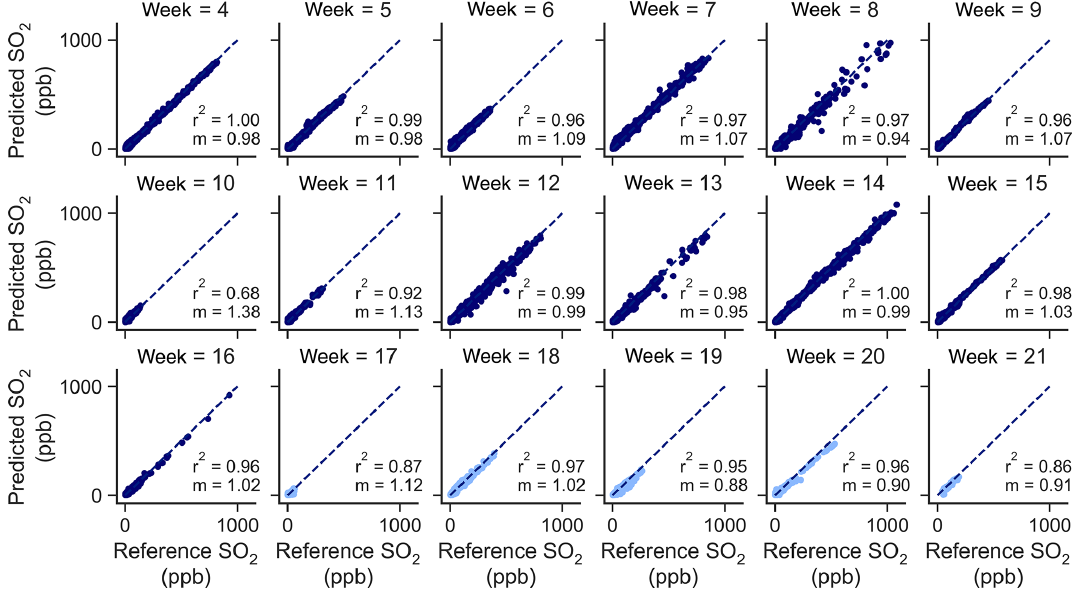
Figure 9. Sensitivity decay for a single SO2-B4 sensor (SO2-02) across 18 weeks. After being trained on data from weeks 2 to 3, the sensor was evaluated using the hybrid regression approach for each successive week of data and fit using ordinary least-squares regression. Slope indicates whether the model was underpredicting ( m < 1) or overpredicting ( m > 1) SO 2 values. A decrease in sensitivity would be seen as a gradual decline in the slope, which is not seen here. Light blue points (weeks 17–21) denote periods during which the RHT sensor was behaving erratically, limiting the amount of useful trusted